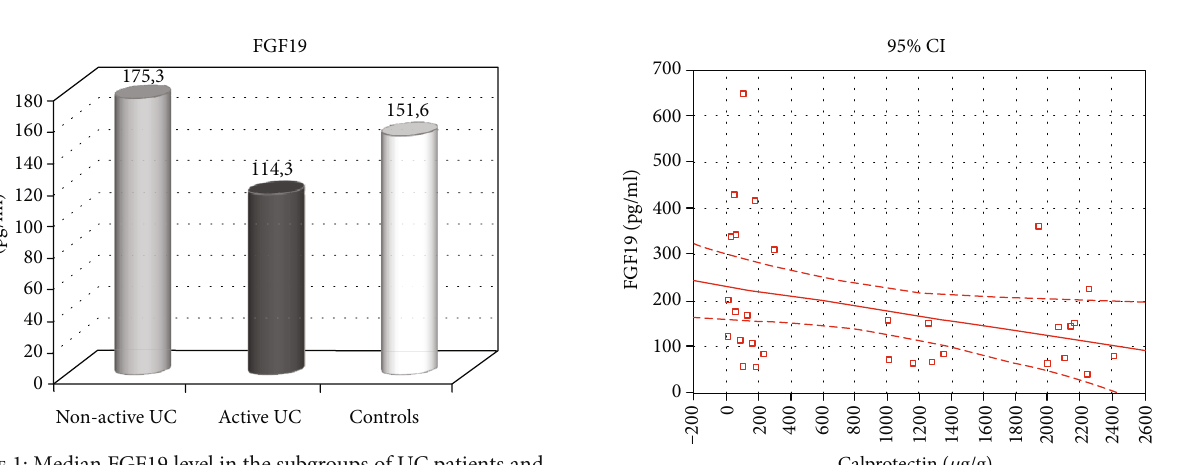
Figure 1: Median FGF19 level in the subgroups of UC patients and the controls. The median serum FGF19 level was lower in patients with active UC than in patients with nonactive UC ( p = 0 : 093 ). There were no statistically signi fi cant di ff erences between the patients with active ( n = 16 ) and nonactive UC ( n = 15 ) compared to the controls ( n = 19 ).